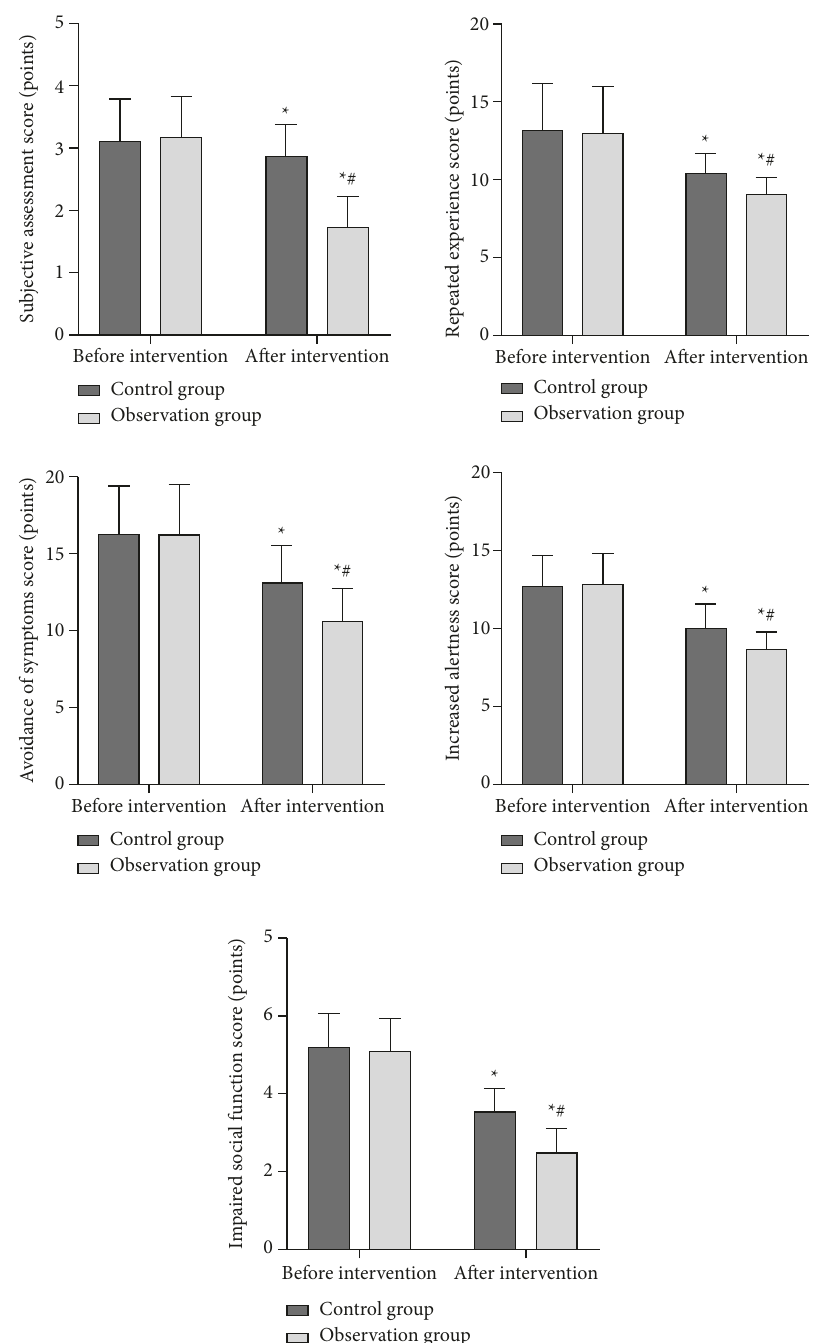
Figure 1: Comparison of stress disorder between two groups. Compared with before intervention, group, # P 0 . <